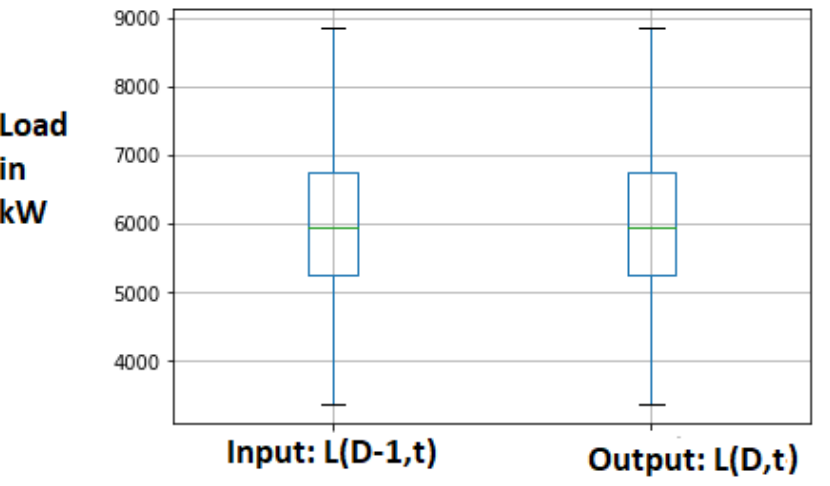
Figure 11. SLR: Data observation using box